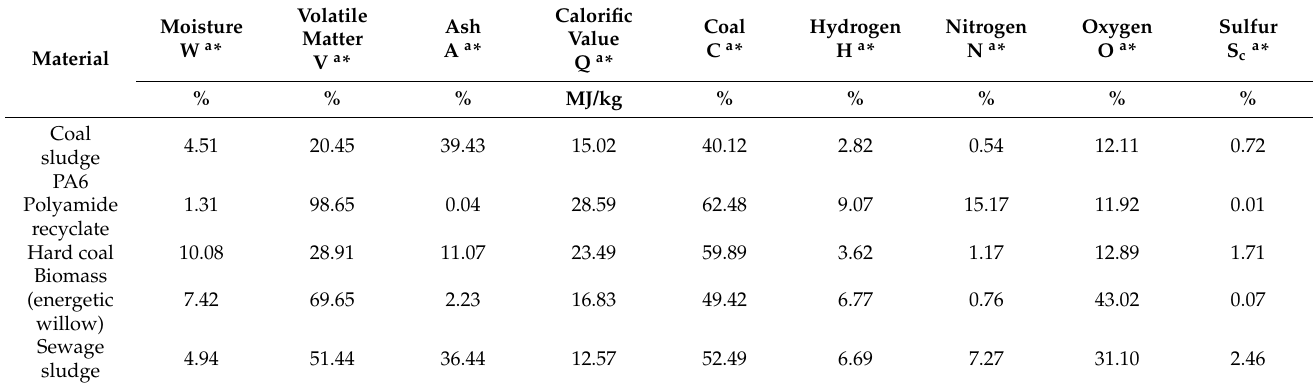
Table 2. Proximate and ultimate analyses of different materials. Made based on [8,9]. a * analytical (air-dry) state of the